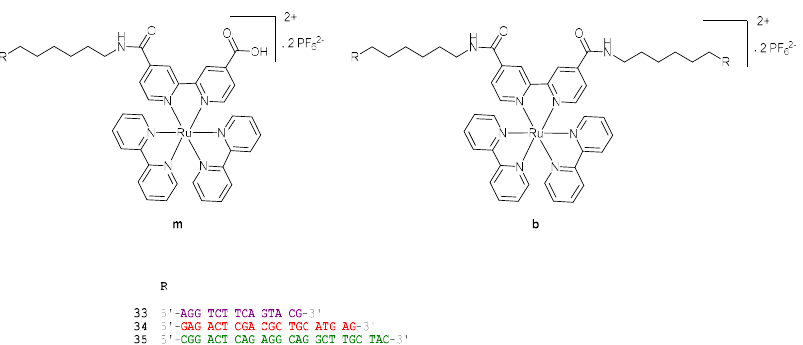
Figure 12. Structures of m33 – m35 mono Ru-DNA and b33 – b35 bis Ru-DNA. Molecules 2018 , 23 , x